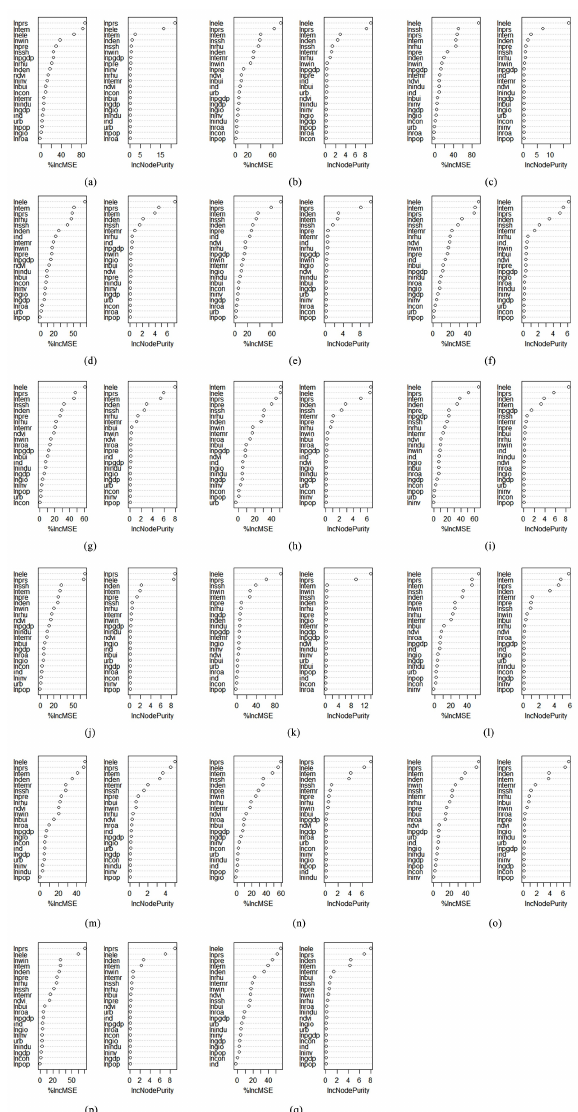
Figure A1. Ranking of importance factors of PM 2.5 concentrations in BTH, 2000–2016. ( a ) 2000; ( b ) 2001; ( c ) 2002; ( d ) 2003; ( e ) 2004; ( f ) 2005; ( g ) 2006; ( h ) 2007; ( i ) 2008; ( j ) 2009; ( k ) 2010; ( l ) 2011; ( m ) 2012; ( n ) 2013; ( o ) 2014; ( p ) 2015; ( q ) 2016. Each variable name is the same as in Figure